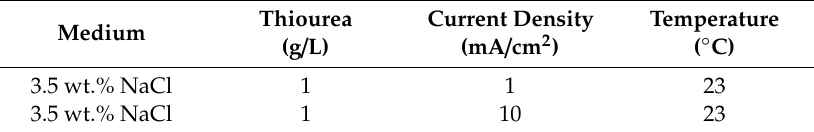
Table 1. Hydrogen Charging Conditions.